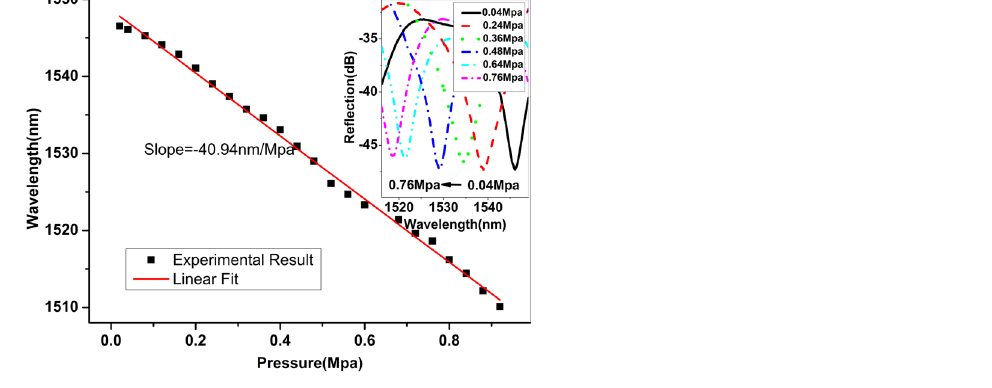
Figure 6. Dip wavelength shift with the increase of pressure, and the inset shows the reflection spectra of the device at different